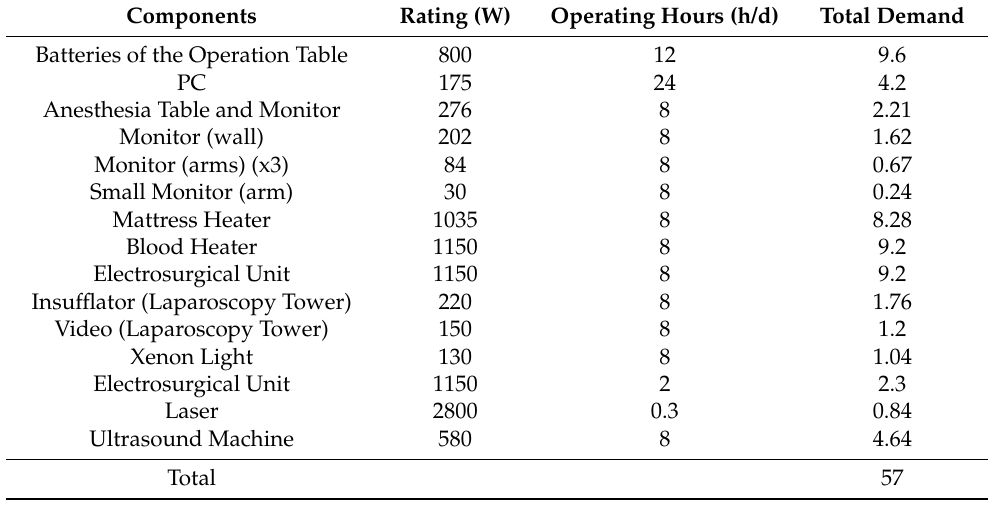
Table 6. Operation theatre load calculation.